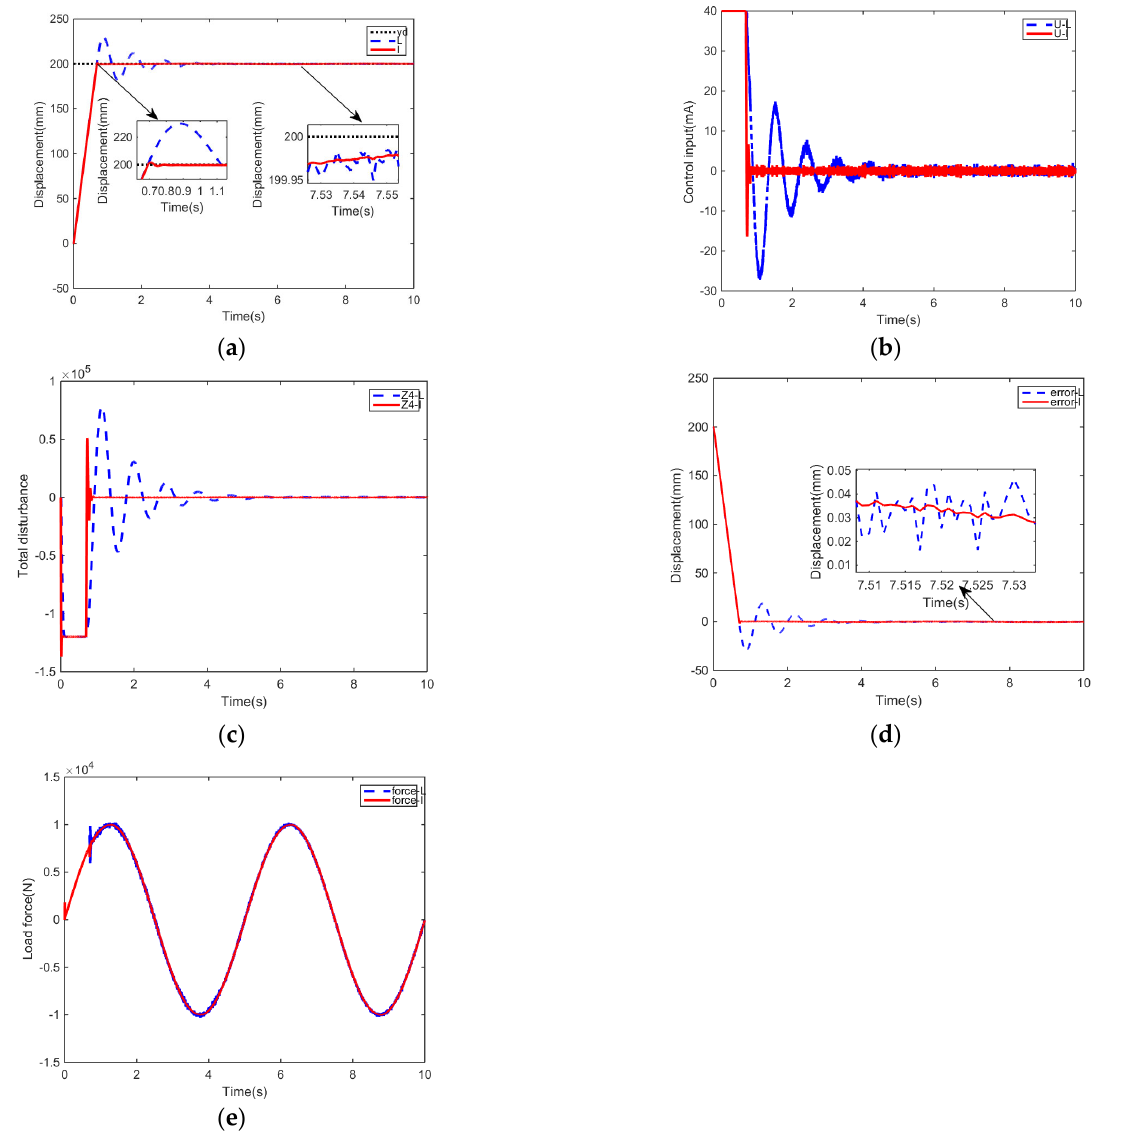
Figure 4. Experimental results of the proposed method and the traditional LADRC method for tracking a constant value trajectory of 200 mm; ( a ) Comparison of tracking performance; ( b ) Comparison of control inputs; ( c ) Comparison of perturbation estimation; ( d ) Comparison of tracking error ( e ) External load force.